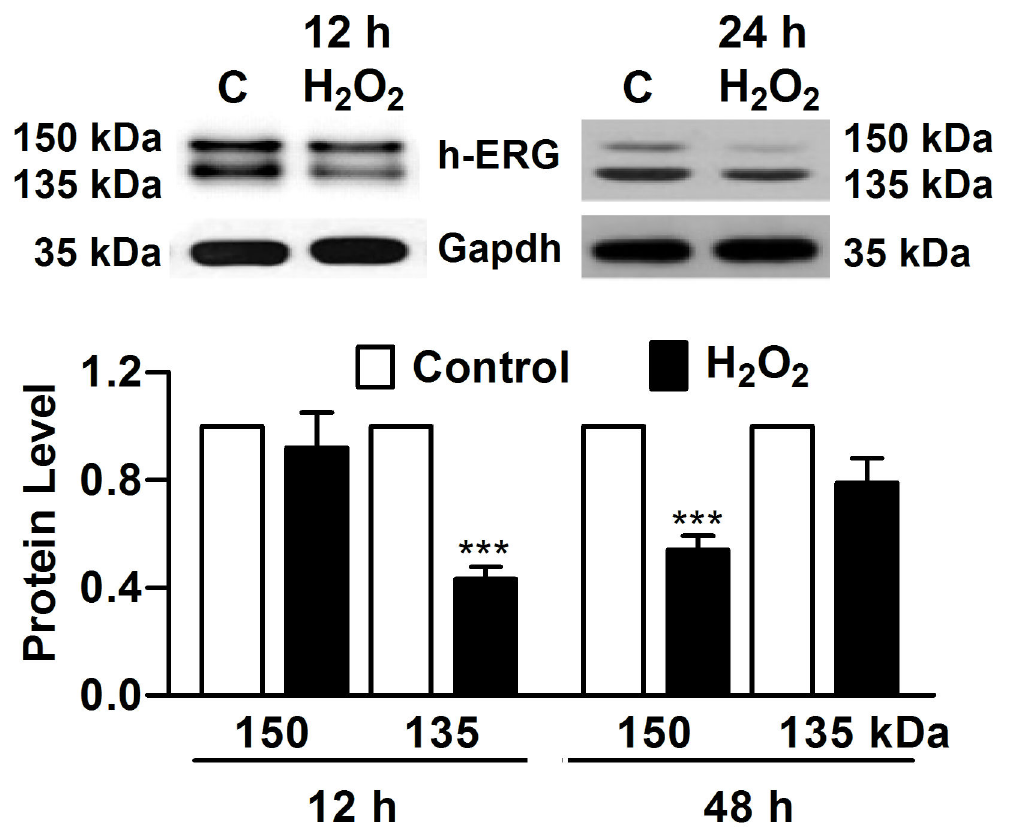
Figure 1. Defective trafficking of h-ERG after chronic oxidative stress in HEK293 cells stably expressing the h-ERG gene. Cells were incubated with H O (40 nmol/L) and h-ERG protein was detected using Western blot analysis at 12 h and 48 h 2 2 after oxidative stress. H-ERG protein appeared ass double bands with the lower band (135 kDa) representing the immature core glycosylated protein situated in endoplasmic reticulum (ER) and the higher band (155 kDa) for the mature fully glycosylated h-ERG being incorporated into the cytoplasmic membrane. C: Control. *** P <0.001 H O vs Control; n=6. 2 2